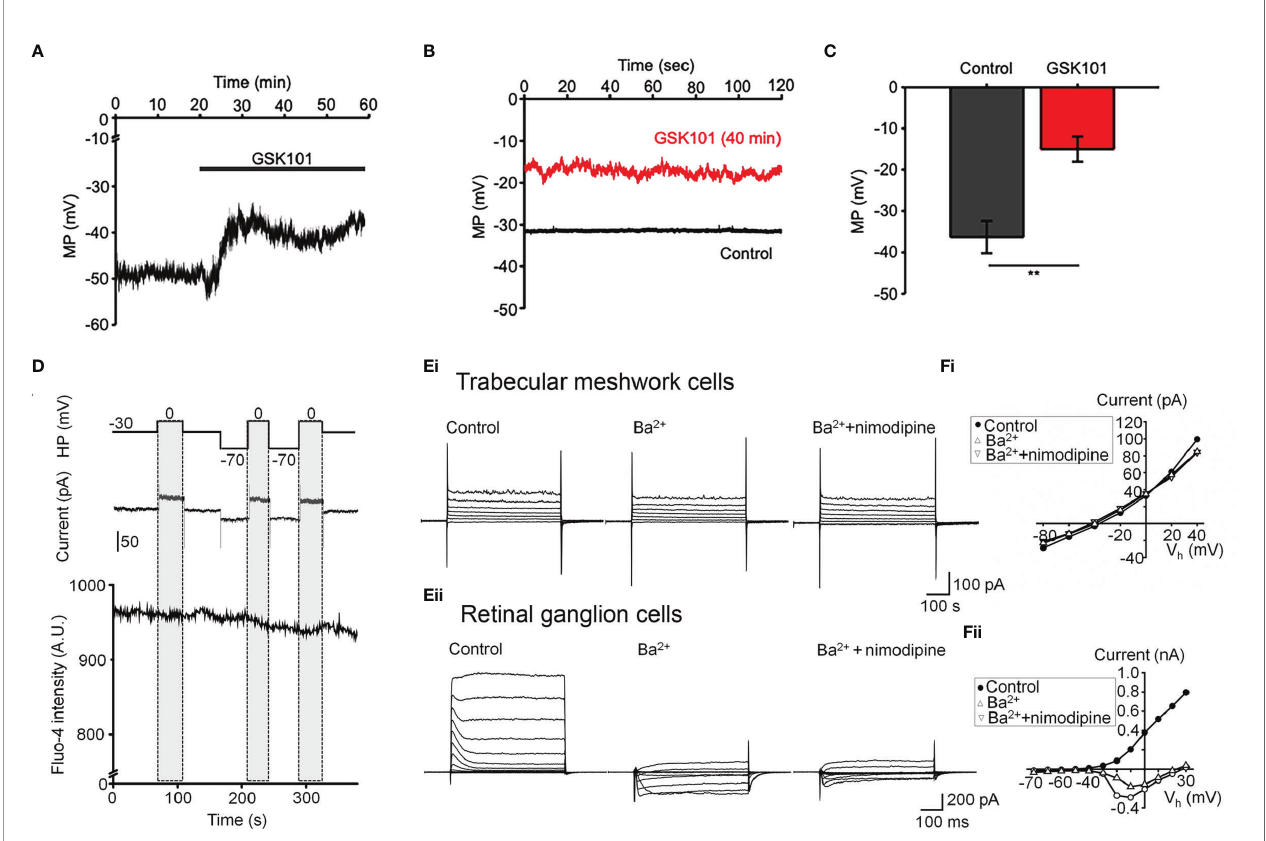
FIGURE 3 | GSK101 depolarizes TM cells, but they lack functional L-type voltage-operated Ca 2+ channels (A – C) Current clamp. GSK101 depolarizes the cells, with the effect maintained over 40 min (red trace vs. black trace denoting the unstimulated control in B). (D) Combined whole cell recording and calcium imaging. The voltage protocol (upper trace), depolarization-evoked whole-cell current (middle trace), time-lapse of Fluo-4 fl uorescence (lower trace). Shadowed bars indicate the depolarizing steps. (E, F) Representative whole-cell currents elicited by voltage steps in TM cells (Ei; n = 15) (B) and mouse retinal ganglion cells (Eii; n = 5), respectively. (F) Voltage-current relationships derived from cells shown in (E) . The current was measured at the end of each voltage